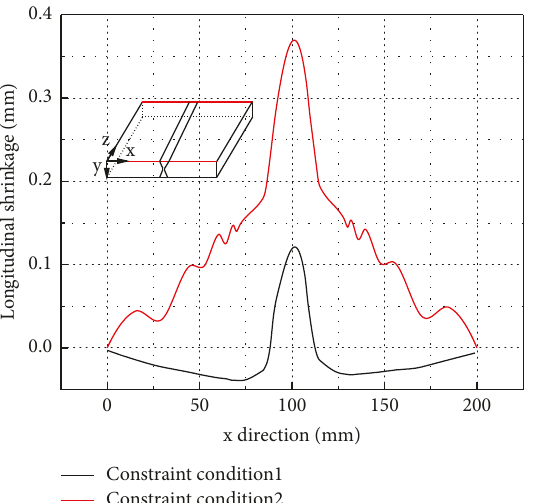
Figure 24: Effect of the constraint conditions on the longitudinal shrinkage.